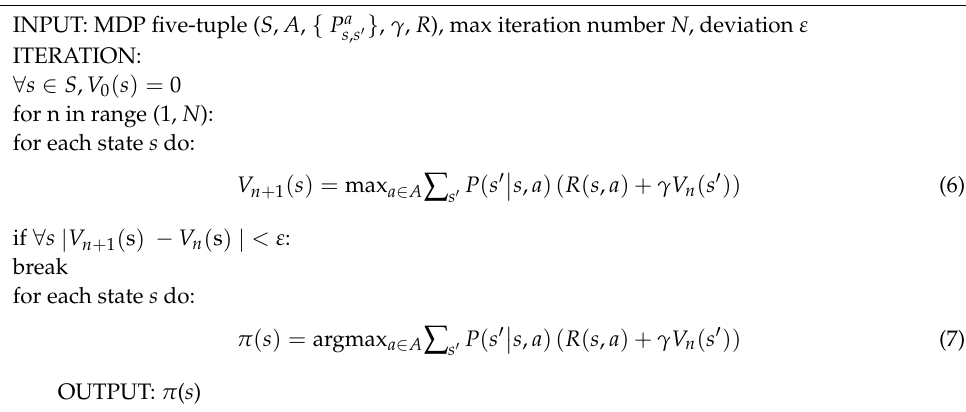
Algorithm 1. The Value Iteration in the MDP